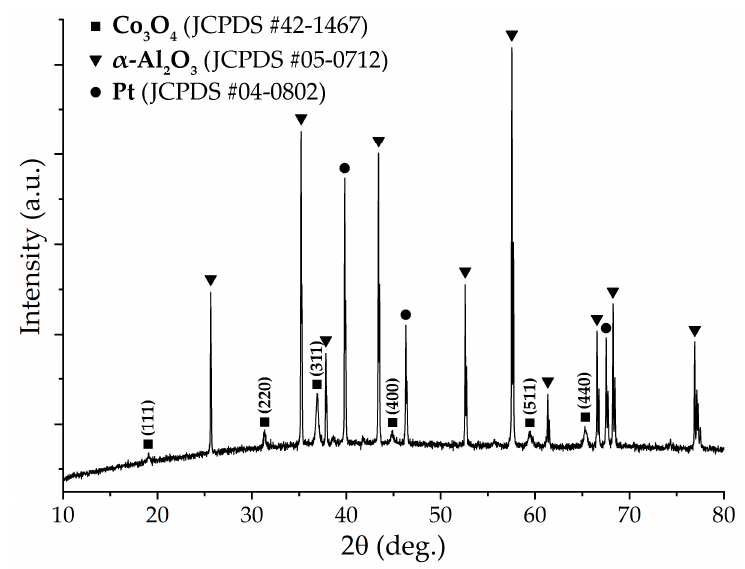
Figure 6. XRD pattern of Co 3 O 4 film printed on the Pt/Al 2 O 3 /Pt chip surface.